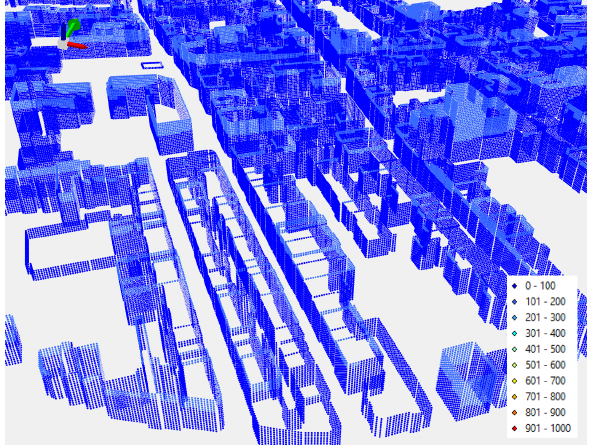
Figure 8. Cost of generated electricity per fac¸ade in [Euro/kWh] (clipping, south-west city